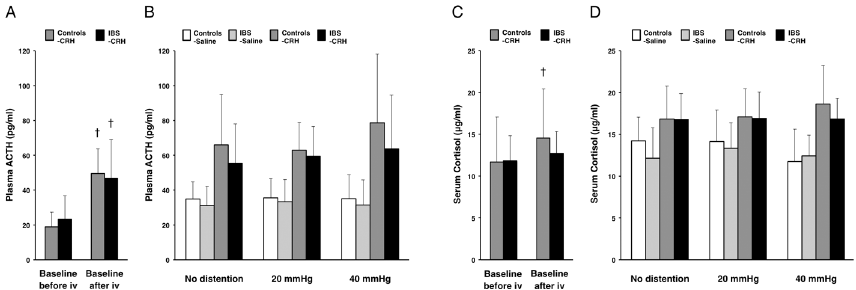
Fig 3. Effects of CRH on the hypothalamic-pituitary-adrenocortical axis. ( A ) Plasma ACTH (pg/ml) at baselines between before and after CRH injection in controls with CRH (n = 8) and IBS patients with CRH (n = 8). iv, intravenous injection. Results represent mean ± SD. † P < 0.05, compared with each baseline, paired t-test. ( B ) A significant drug effect and drug × distention interaction in plasma ACTH (pg/ml) during random distention after drug injection was noted between controls with saline (n = 8), IBS patients with saline (n = 8), controls with CRH (n = 8) and IBS patients with CRH (n = 8), analyzed by GEE. ( C ) Serum cortisol ( μ g/ml) at baselines between before and after CRH injection. † P < 0.05, compared with each baseline. ( D ) Serum cortisol ( μ g/ml) during random distention after drug injection had a significant drug effect, drug × distention interaction and drug × distention × group interaction by GEE analysis.